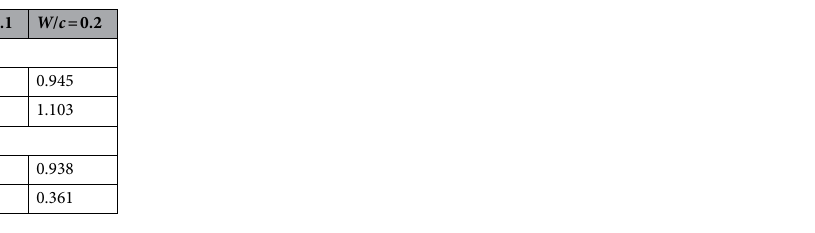
Table 2. Aerodynamic force coefficients of wings with different wing